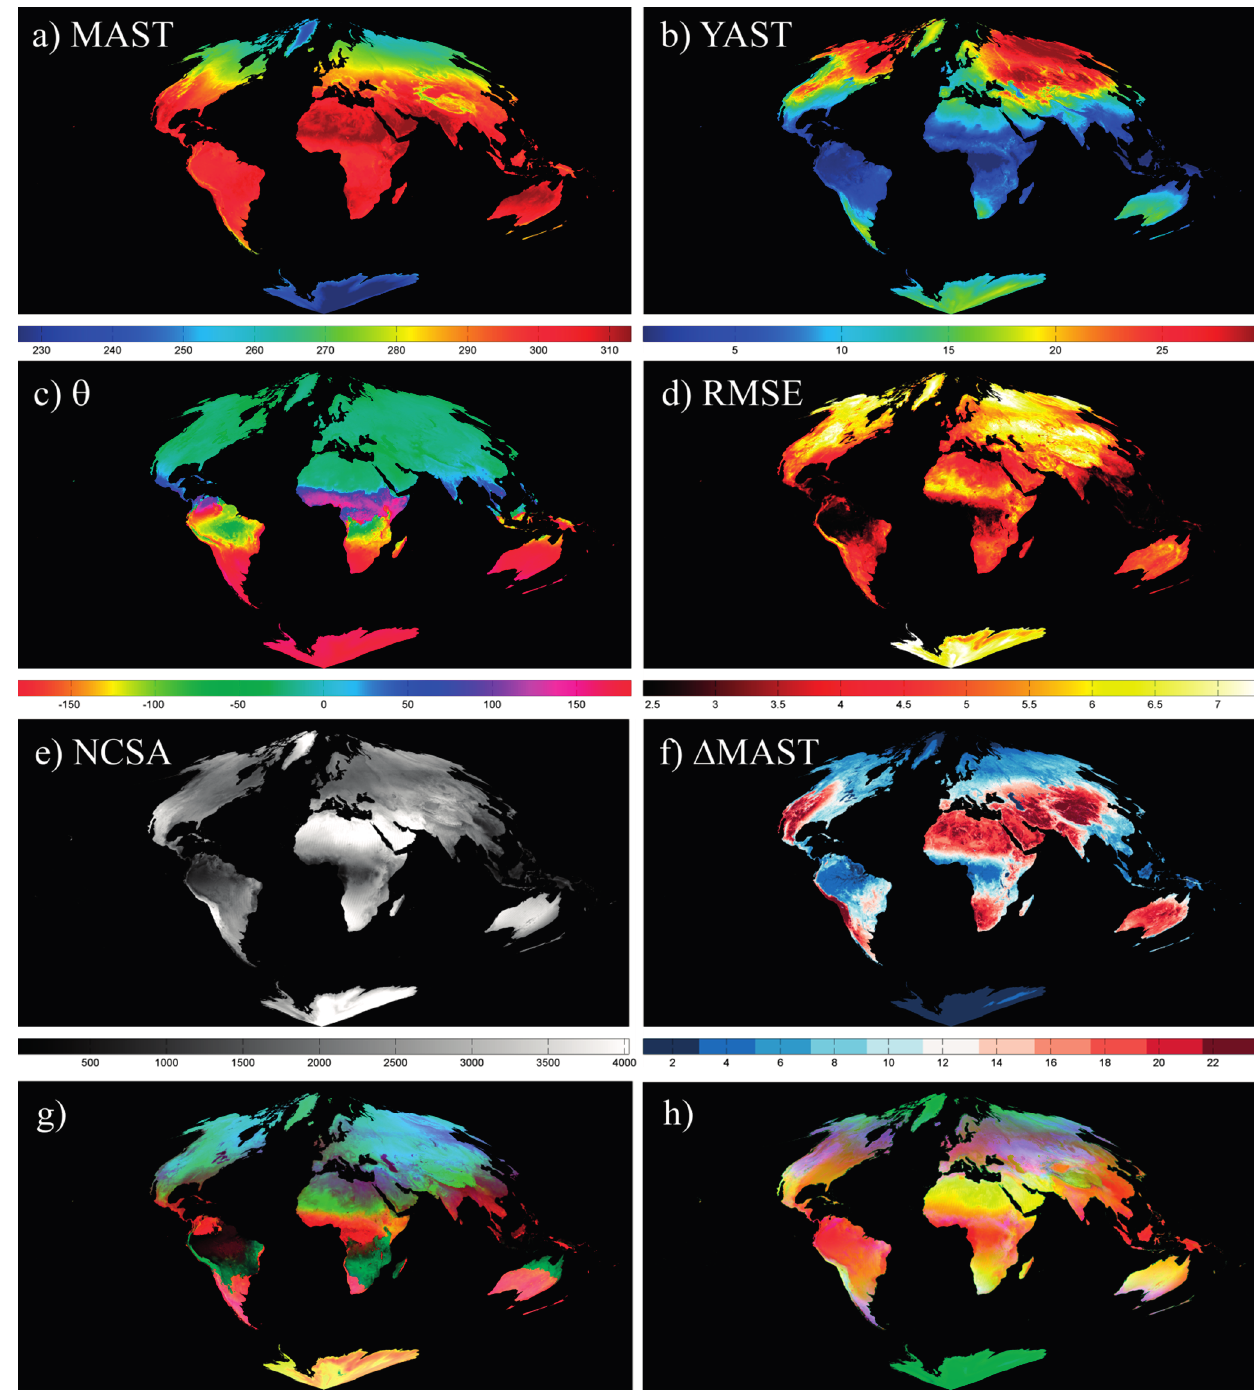
Figure 5. Results of the global ACP modelling experiment including all observations from 2000–2013. ( a ) Daytime mean annual surface temperature (MAST) in K; ( b ) Daytime yearly amplitude of surface temperature (YAST) in K; ( c ) Daytime phase shift θ in days; ( d ) Daytime RMSE of fit in K; ( e ) Number of daytime clear sky acquisitions (NCSA); ( f ) ∆ MAST between day- and nighttime as measure for the amplitude of the diurnal temperature cycle in K; ( g ) RGB color composite of θ -RMSE-YAST; ( h ) Composite of MAST-NCSA- ∆ YAST day-night . The annual amplitude YAST increases from the equator to the poles which demonstrates increasing seasonality associated with higher latitudes. Moreover YAST increases with continentality (e.g., in